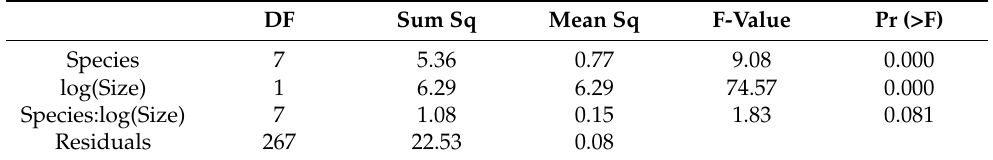
) = Species × log ( Size ) . M a